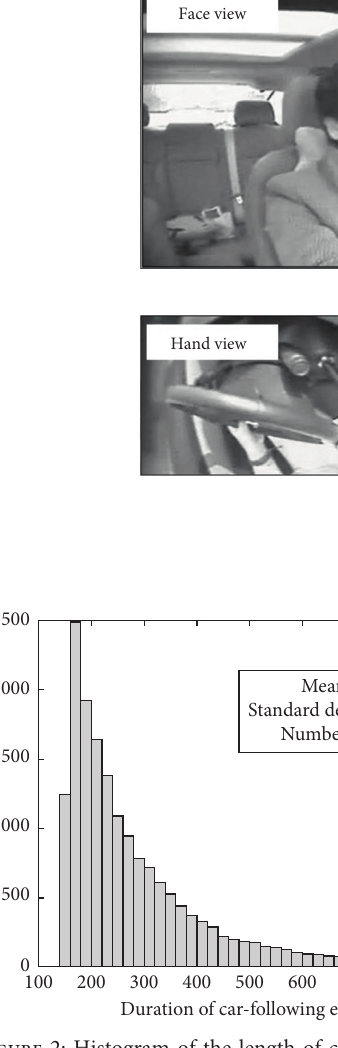
Figure 2: Histogram of the length of car-following events.